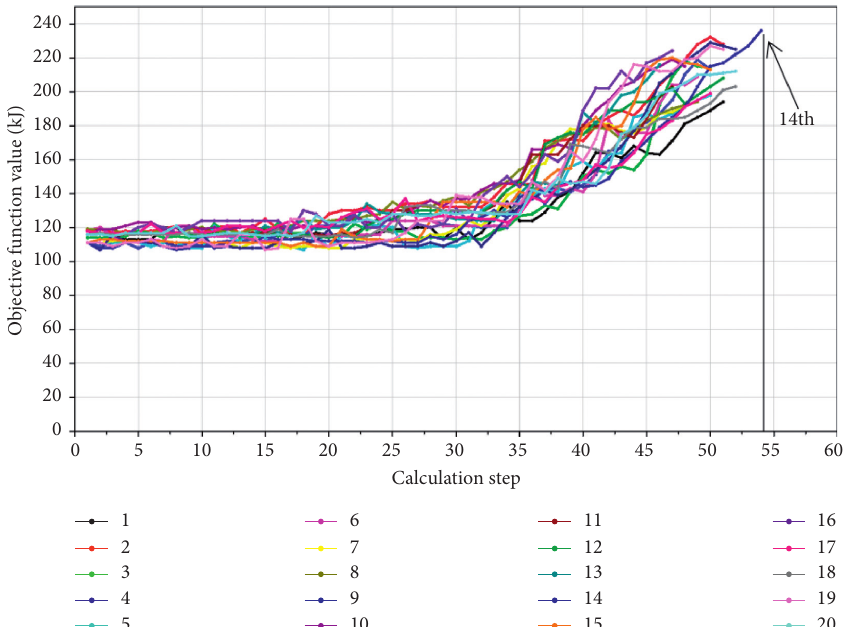
Figure 6: Objective function varying with calculation step.